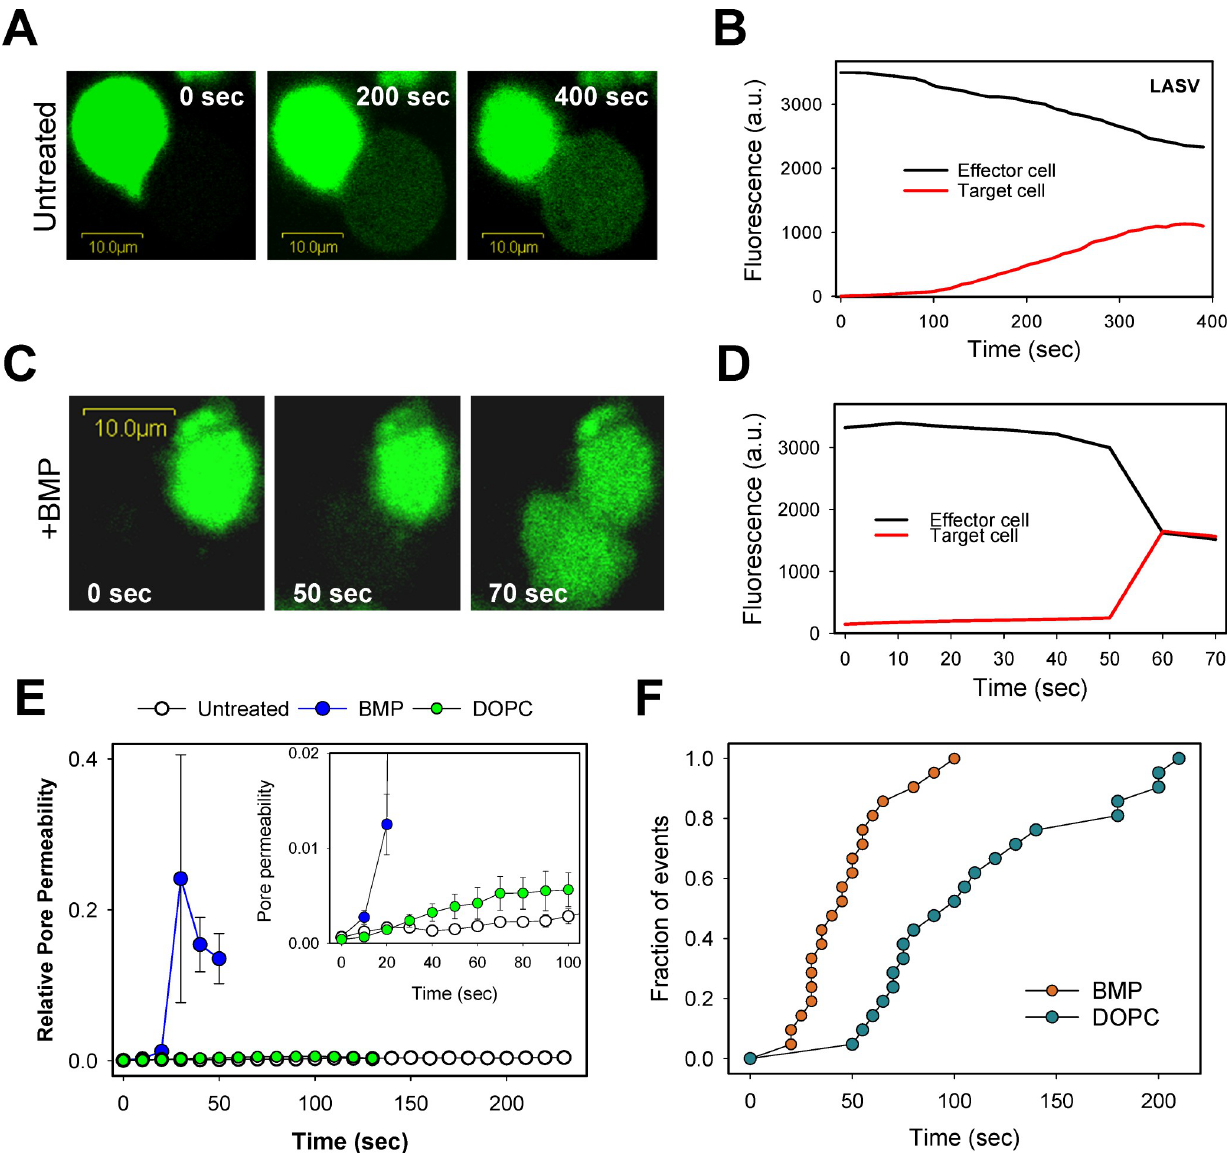
Fig 6. BMP markedly promotes the formation and enlargement of LASV GPC-mediated fusion pores. Effector COS7 cells expressing GPC were loaded with calcein (green), mixed with unlabeled 293T cells and adhered to poly-lysine coated coverslips. Cells were then pre-treated with 20 μ g/ml of BMP or DOPC for 10 min at room temperature or left untreated. Cell-cell fusion was triggered by transferring cells to a pH 5.0 buffer and quickly raising the temperature to 37˚C through an IR temperature jump protocol (see Materials and Methods). (A, B) Snapshots and fluorescence intensities showing partial calcein redistribution between untreated effector and target (dye donor and acceptor) cells. (C, D) Same as in panels A, B, but for cells pretreated with BMP. (E) Ensemble average of permeabilities of six fusion pores for untreated and DOPC- or BMP-treated cells. Individual pore permeability traces calculated as described in Materials and Methods were aligned so that t = 0 represents a time point immediately before dye redistribution was detected. Inset : Initial permeability profiles of fusion pores. Error bars are SEM. (F) Kinetics of fusion pore formation for control and BMP-treated cells. The data points represent time after raising the temperature until the onset of calcein transfer.